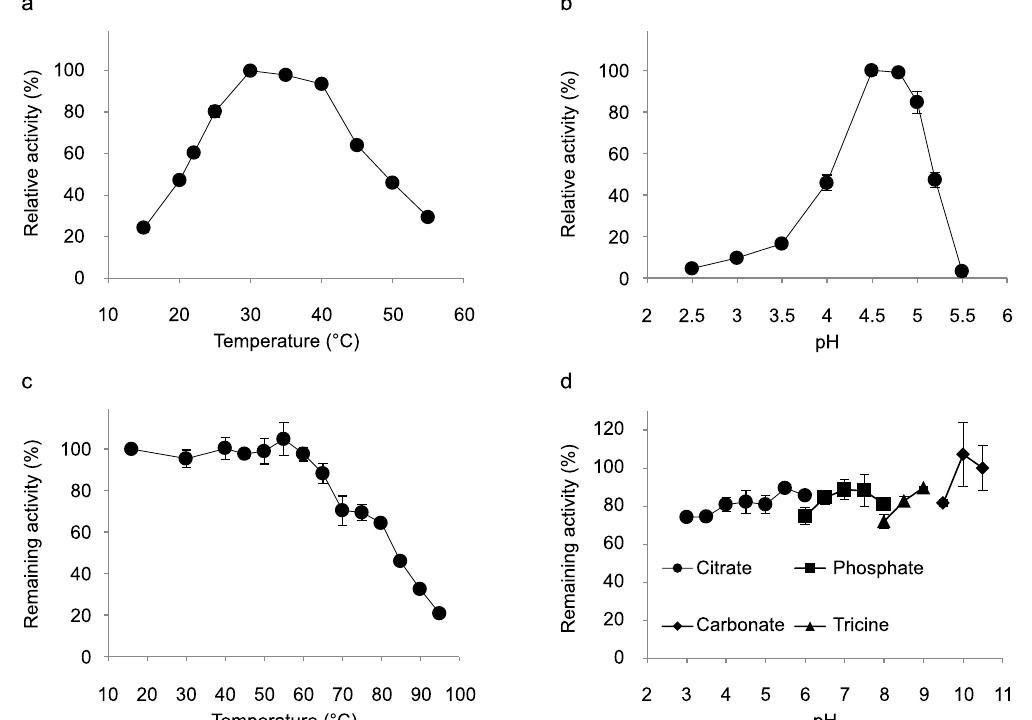
Figure 4. Effect of temperature and pH on recombinant Pton3HNL. ( a ) Optimum temperature. Reaction was performed at 15–55 °C for 5 min in 300 mM sodium citrate buffer, pH 4.2. ( b ) Optimum pH. Reaction was performed at 22 °C for 5 min in 300 mM sodium citrate buffer (pH 2.5–5.5). ( c ) Temperature stability. Remaining activity was measured after incubation of Pton3HNL at various temperatures (15–95 °C) in 10 mM potassium phosphate buffer, pH 7.0, for 60 min. ( d ) pH stability. Remaining activity was measured after incubation of Pton3HNL at 25 °C for 60 min with the following buffers: 100 mM sodium citrate buffer (pH 3.0–6.0); 100 mM potassium phosphate buffer (pH 6.0–8.0), 100 mM Tricine-NaOH buffer (pH 8.0–9.0), and 100 mM sodium carbonate buffer (pH 9.5–10.5). Values are mean ± SD; n =